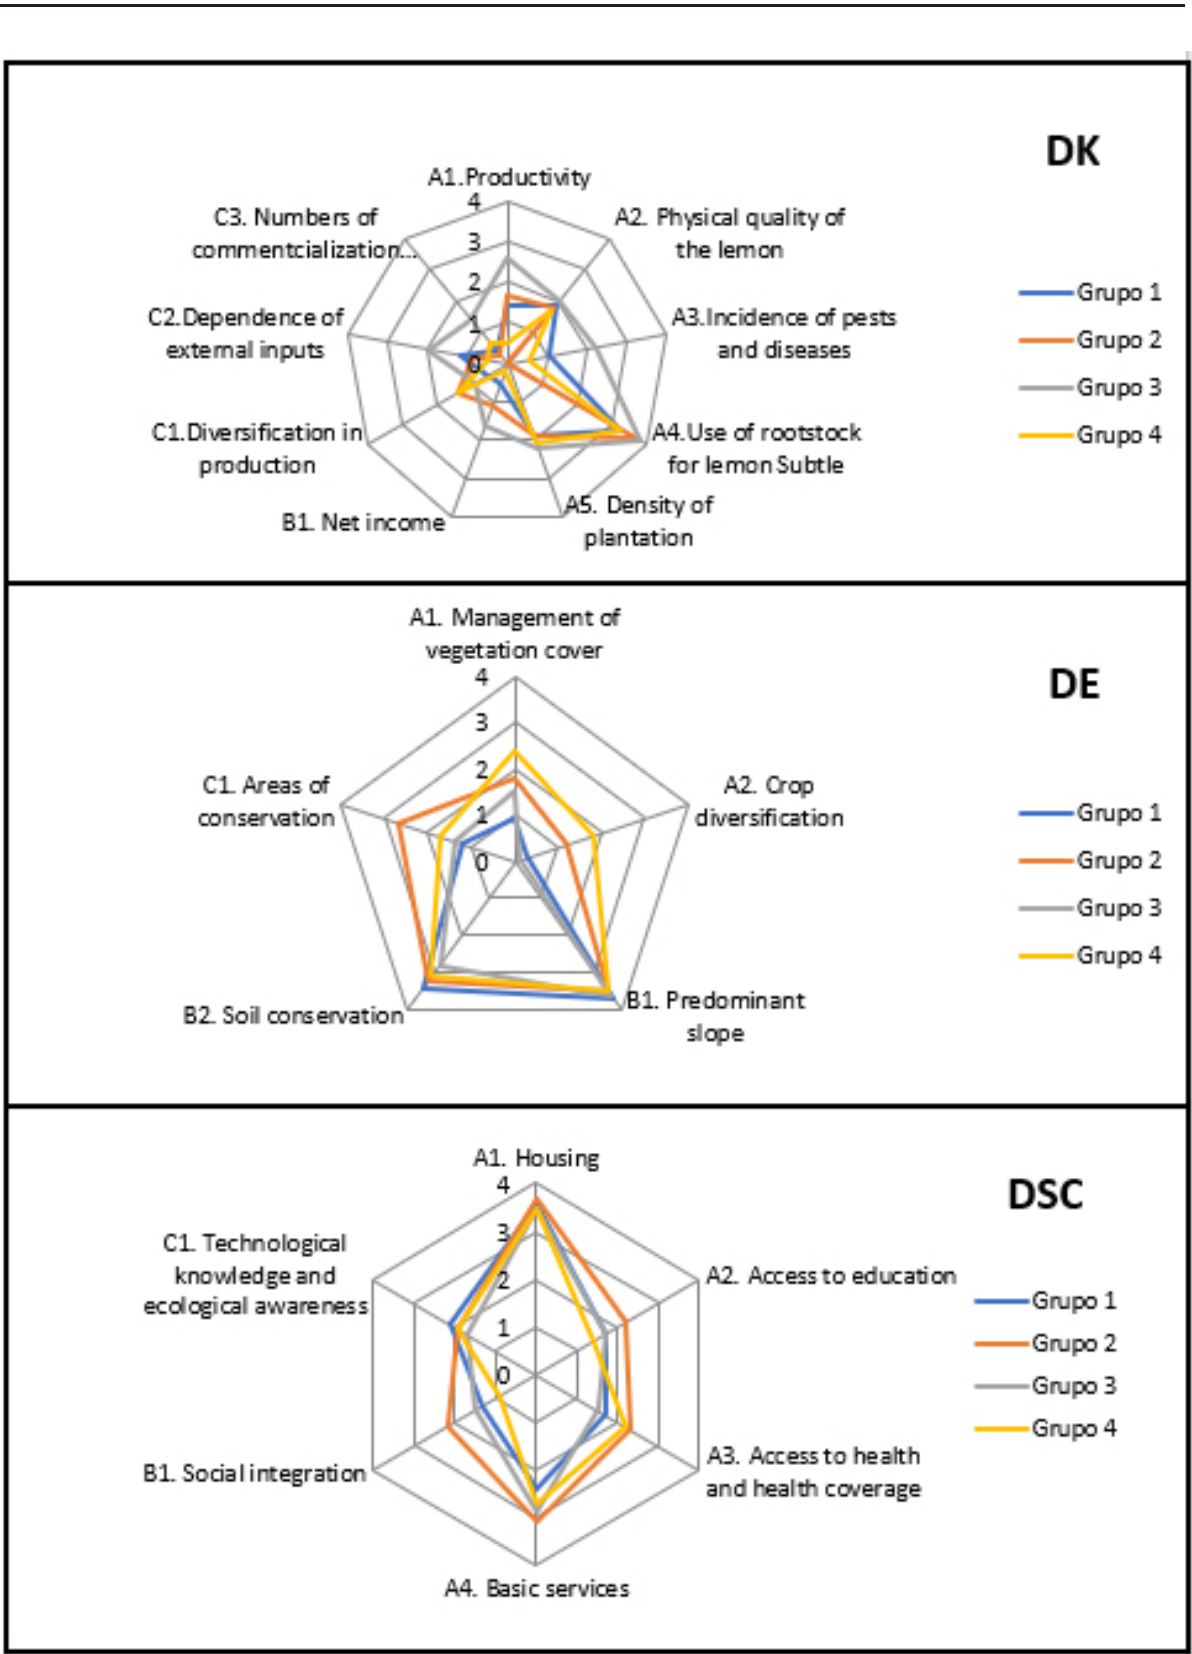
50Figure 3. Critical points of sustainability in the economic (IK), environmental (IE) and sociocultural (ISC) dimensions in “lemon-producing” type farms in Santa Elena,